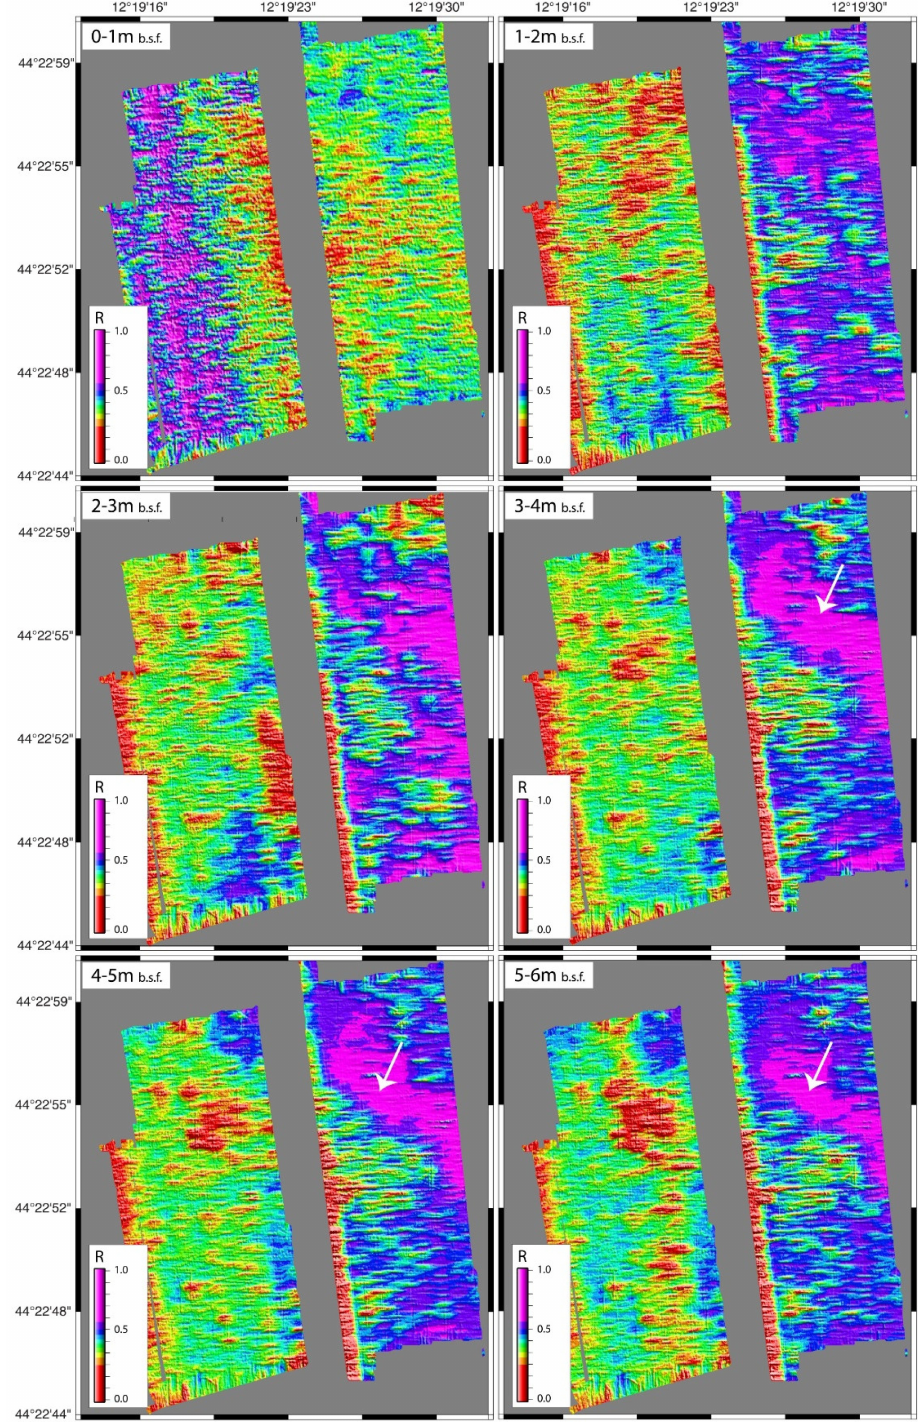
Figure 11. Time slices of reflectivity values at different depths. White arrow indicates a buried erosional channel not observed in the morphobathymetric maps. See also Time_Slices.mp4, Supplementary